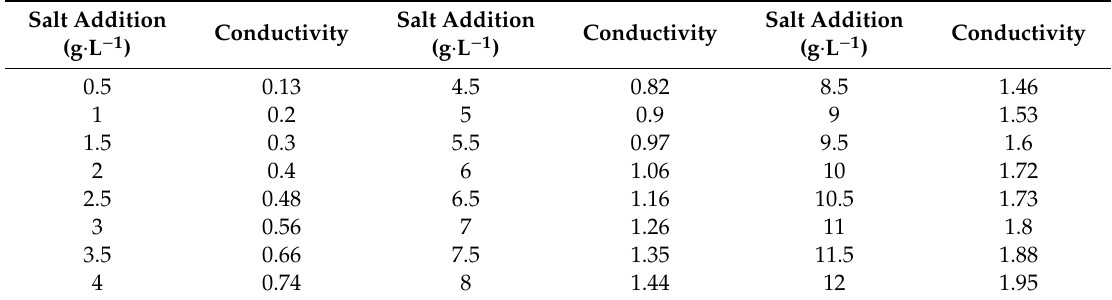
Table A2. The relationship between salt addition and conductivity after dilution.